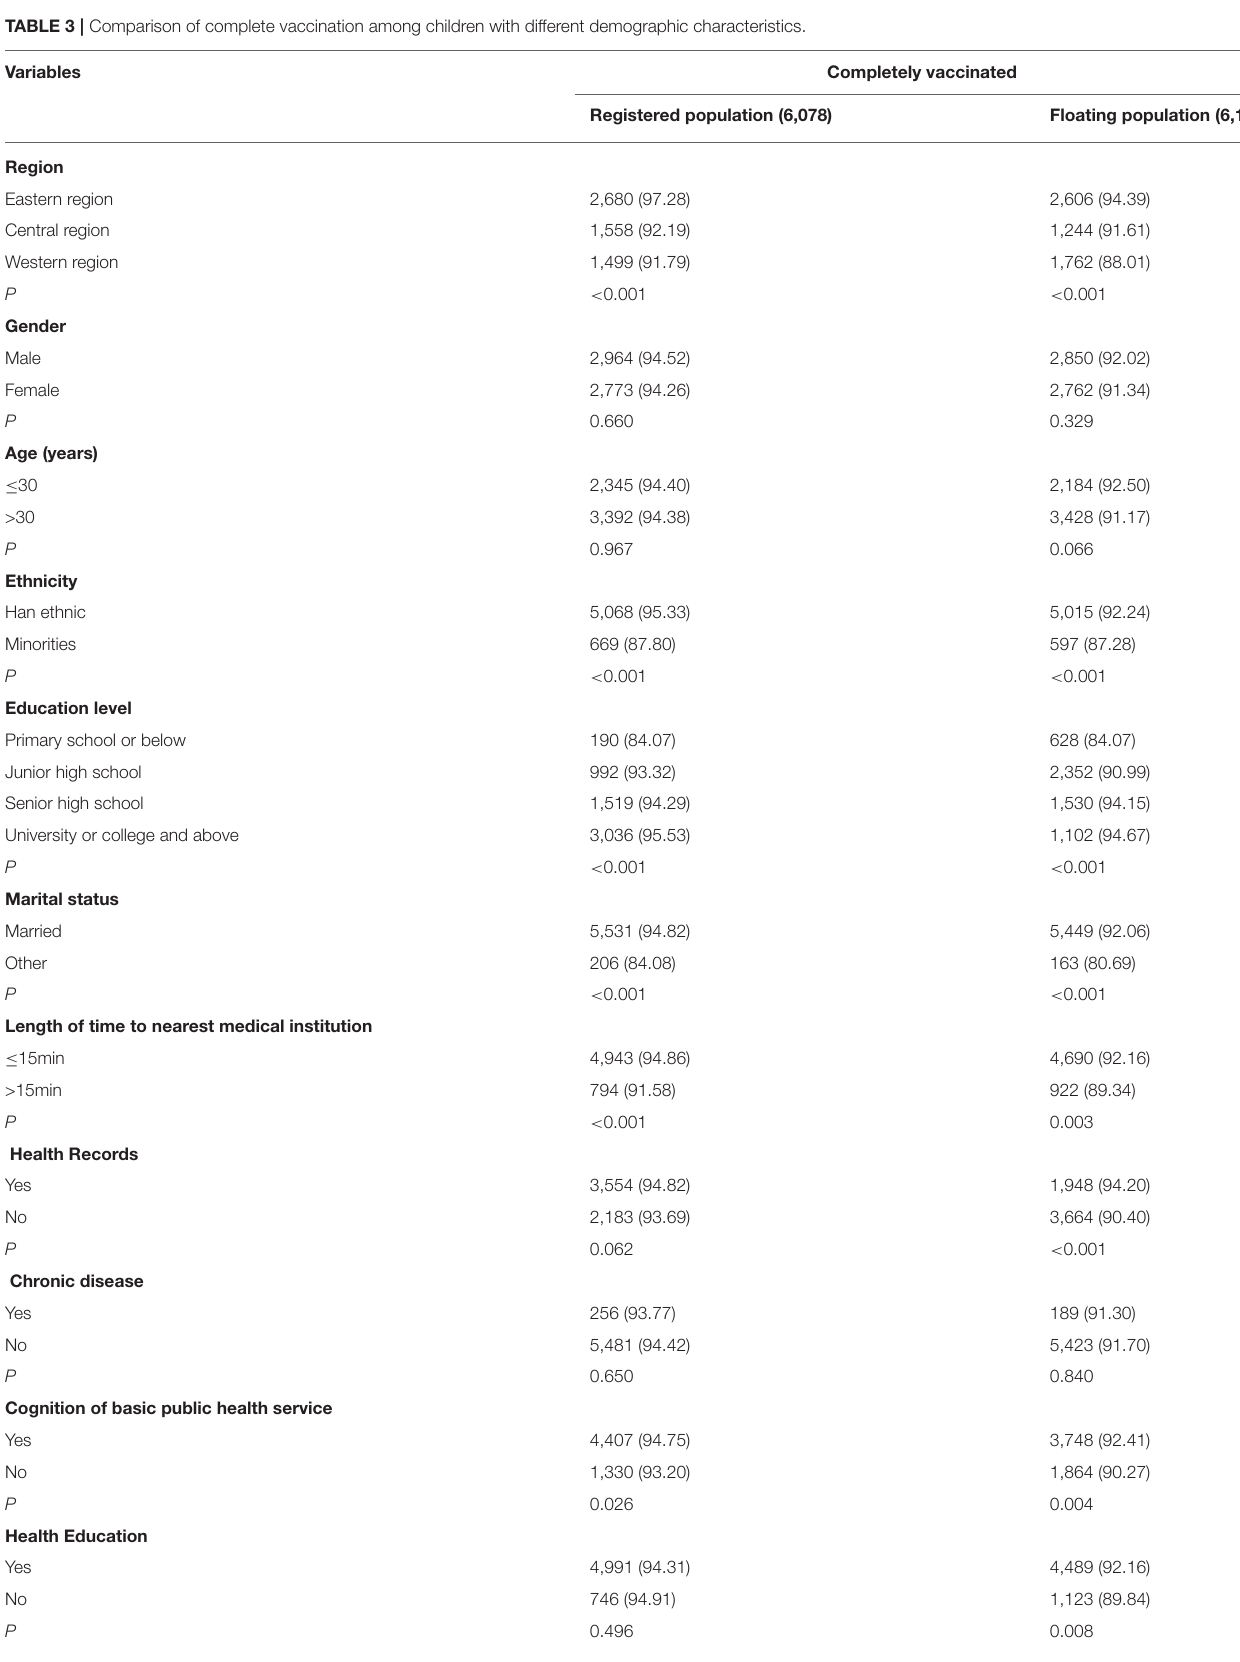
TABLE 3 | Comparison of complete vaccination among children with different demographic